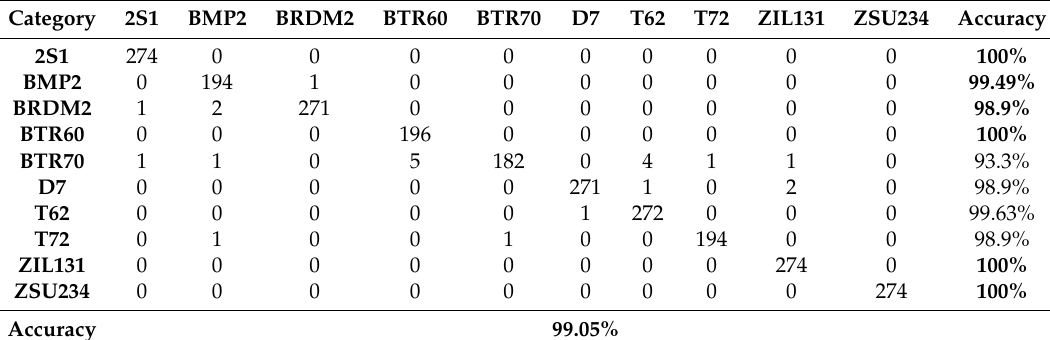
Table 7. Confusion matrix of 10-class recognition results (transfer learning).